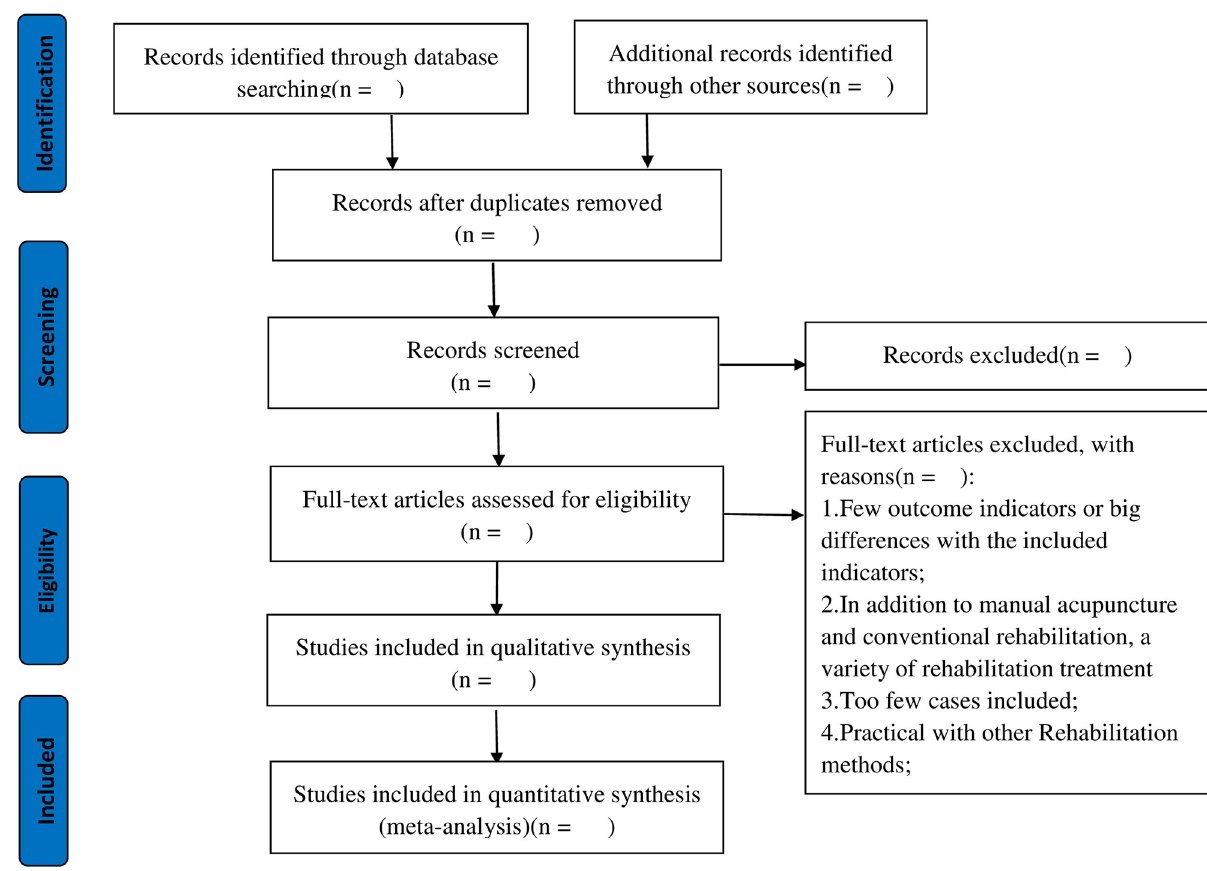
Fig 1. PRISMA flow diagram of study and